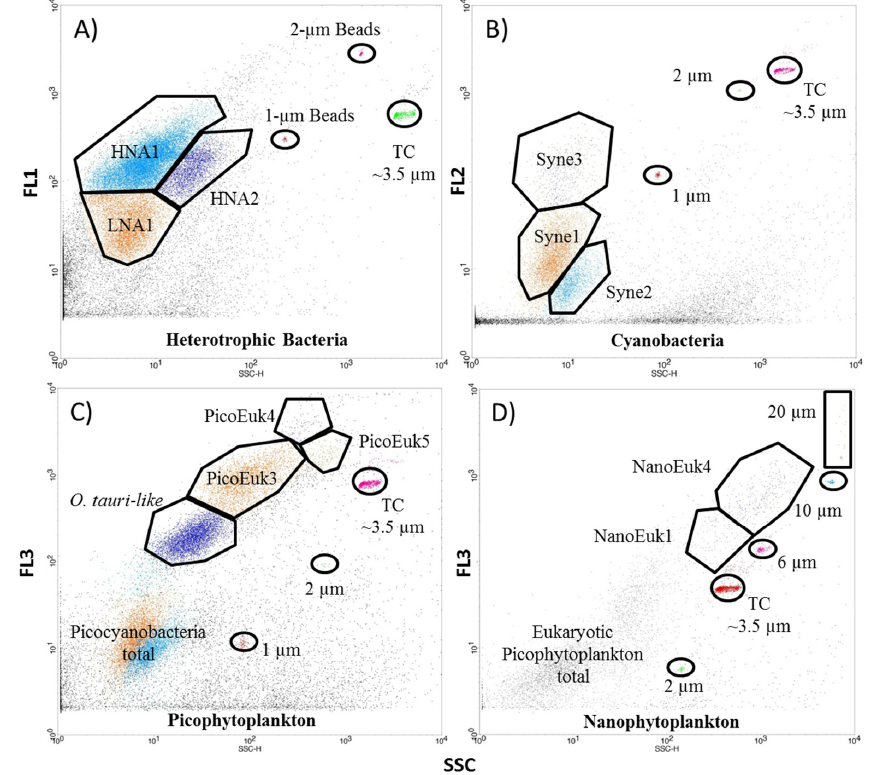
Figure 2. (Color). Examples of cytograms showing the main studied groups of bacteria ( A ), cyanobacteria ( B ), eukaryotic pico- ( C ), and nanophytoplankton ( D ). TC indicates TruCount TM , and beads and SSC on the x-axis: green for bacteria, orange for cyanobacteria, and red for eukaryotic pico- and and 2, NanoEuk2 and